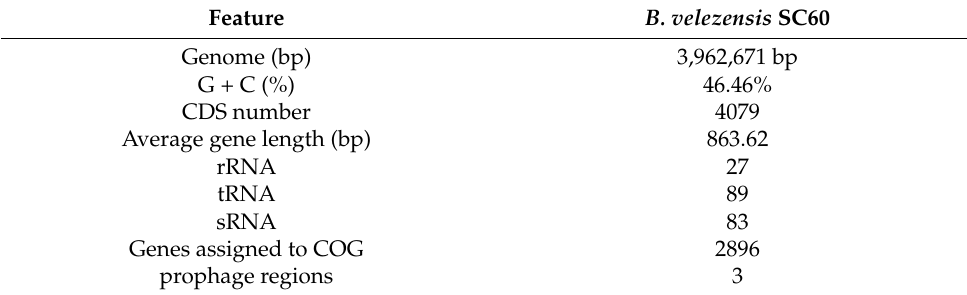
Table 1. General genomic features of Bacillus velezensis SC60.